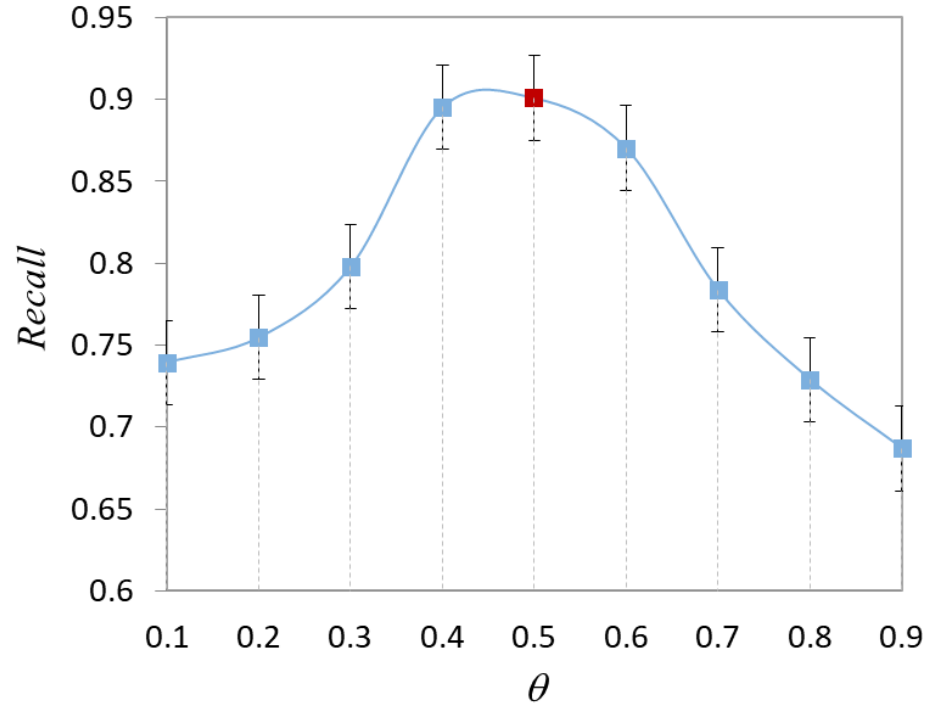
Figure 6. Effect of parameter 𝜃 on model recall.